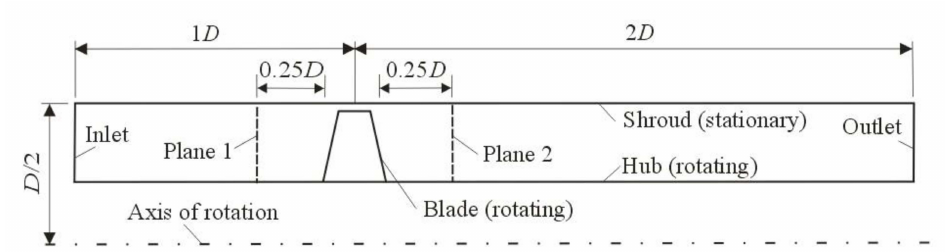
Figure 5. Sketch of the computational domain for creating the database with automated RANS predictions; D ≈ D tip , since the tip clearance is small ( S / D =